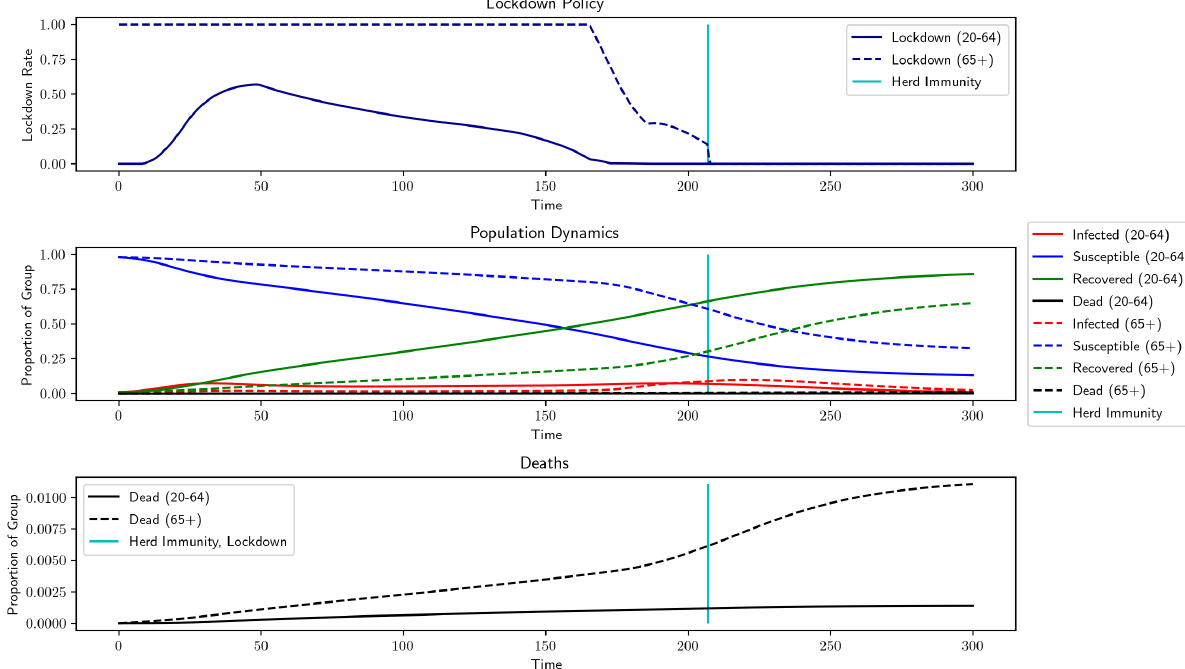
Figure 5. Benchmark—herd immunity: 207 d, output loss: 7.3439%, total deaths: 0.3266%. Benchmark parameters: χ = 10/ r , r = 0.001%, α E = 0.42, h = 0.4, α L = 10 − 5 , α I = 1, ρ = 0.75, F = 1, θ = 0.75, ν = 0.67, η = 10. Death rates from Table 1. Herd immunity =